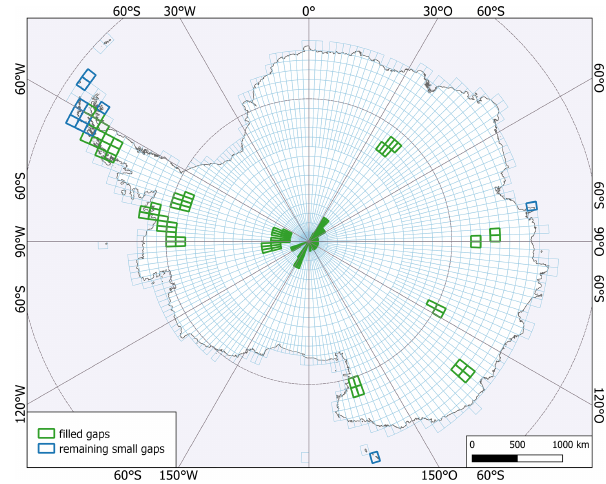
Figure 6. TanDEM-X DEM geocells after DEM gap filling with new acquisitions: geocells with gaps that could be filled are in green. Geocells with remaining smaller gaps after DEM gap filling are in